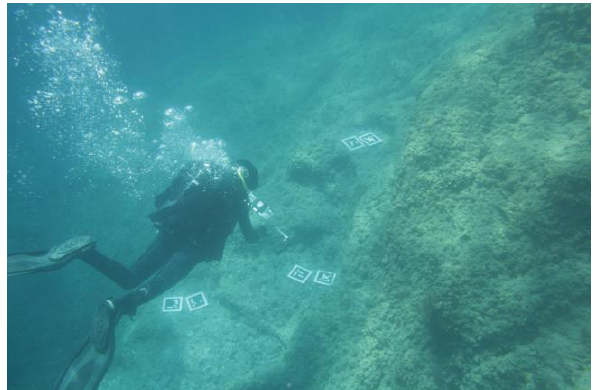
Figure 19. acquisition with marker